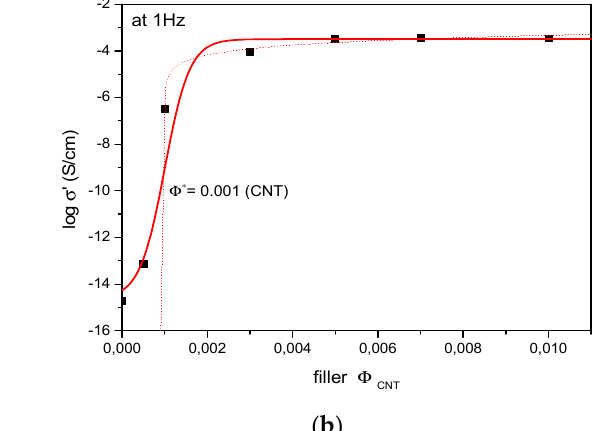
Figure 4. ( a ) Electrical conductivity depending on pretreated CNT concentration and ( b ) estimation of electrical percola- tion threshold.